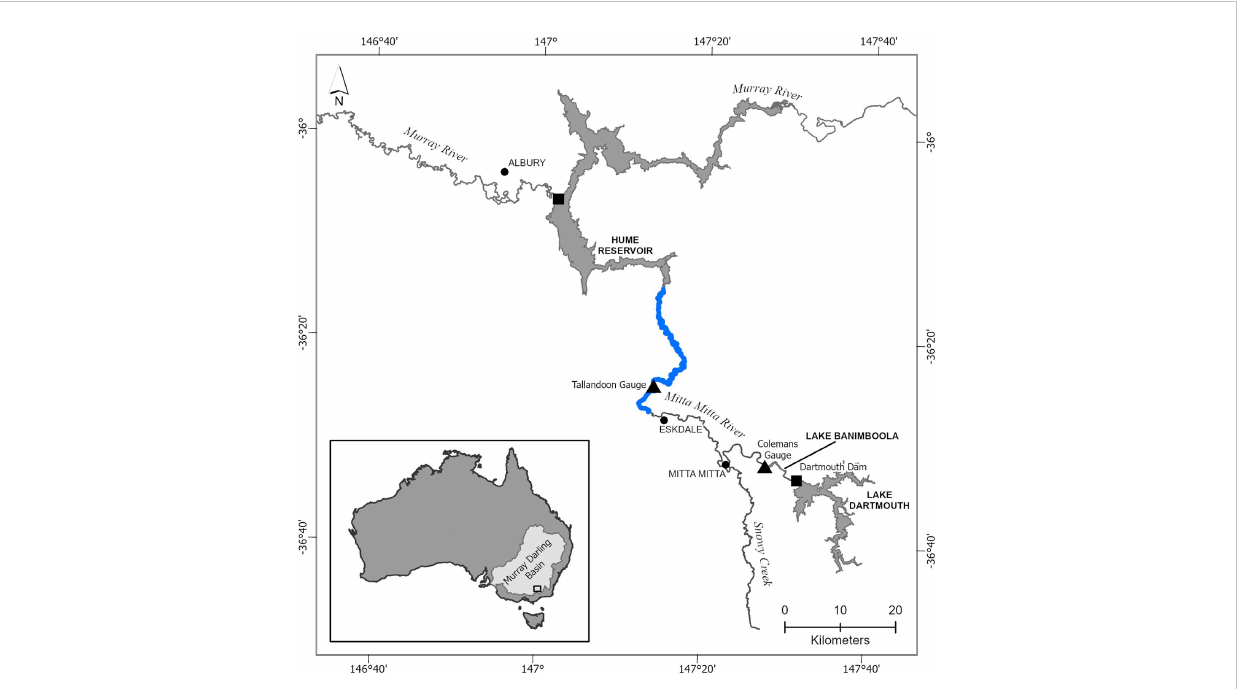
FIGURE 1 Map of the lower Mitta Mitta River. Focus river reach of the study highlighted in blue (48 km). The CWP reach extends from immediately below Lake Dartmouth to Hume Reservoir, approximately 100 km in